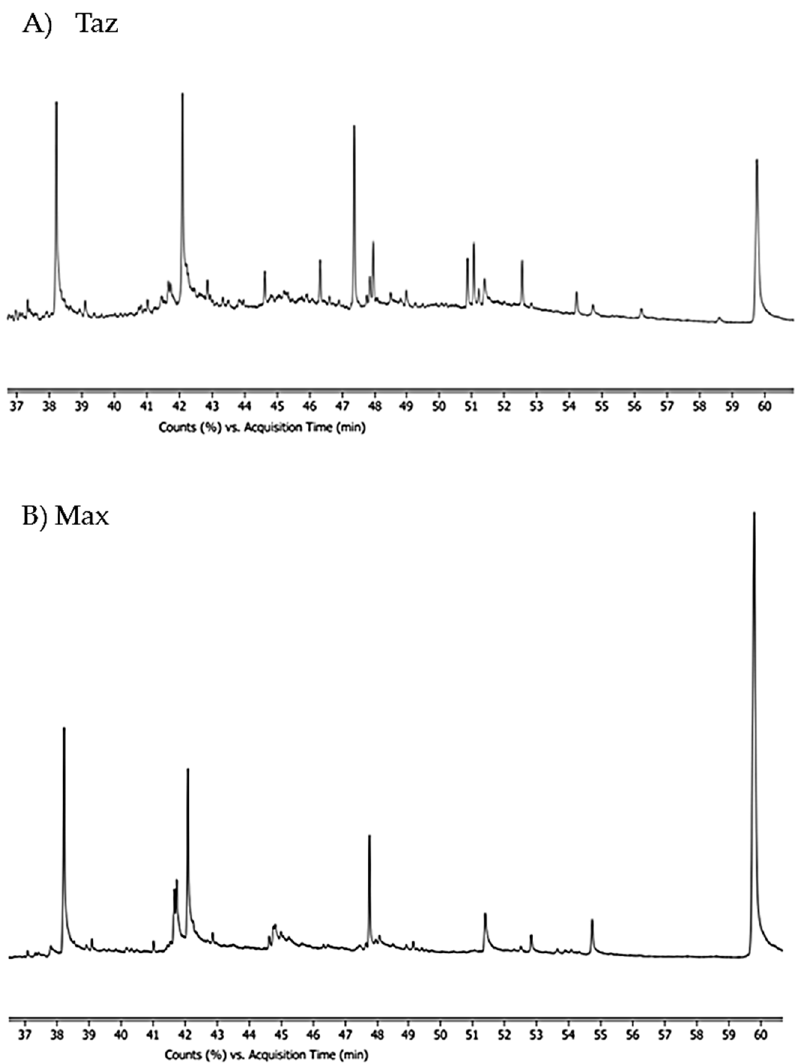
Figure 1. Comparison of GC/MS chromatograms of the two sampled adult male brown bears ( A ) TAZ and ( B ) MAX extracted with hexane. The x-axis is the retention time in minutes.